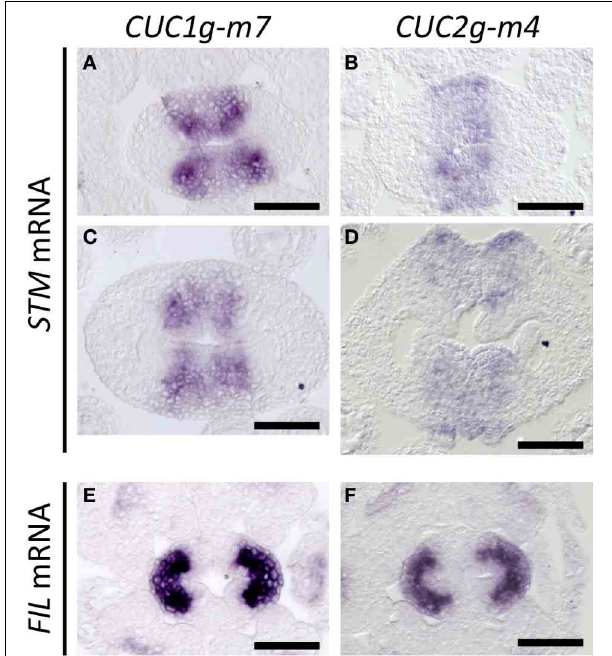
FIGURE 7 | STM and FIL expression in CUC1g-m7 and CUC2g-m4 . In situ hybridization on transverse sections from developing gynoecia of CUC1g-m7 (A,C,E) and CUC2g-m4 (B,D,F) probed with STM (A–D) and with FIL (E,F) at early stage 9 (A,B) , late stage 9 (C,D) and stage 8 (E,F) . Scale bars are 50 µ